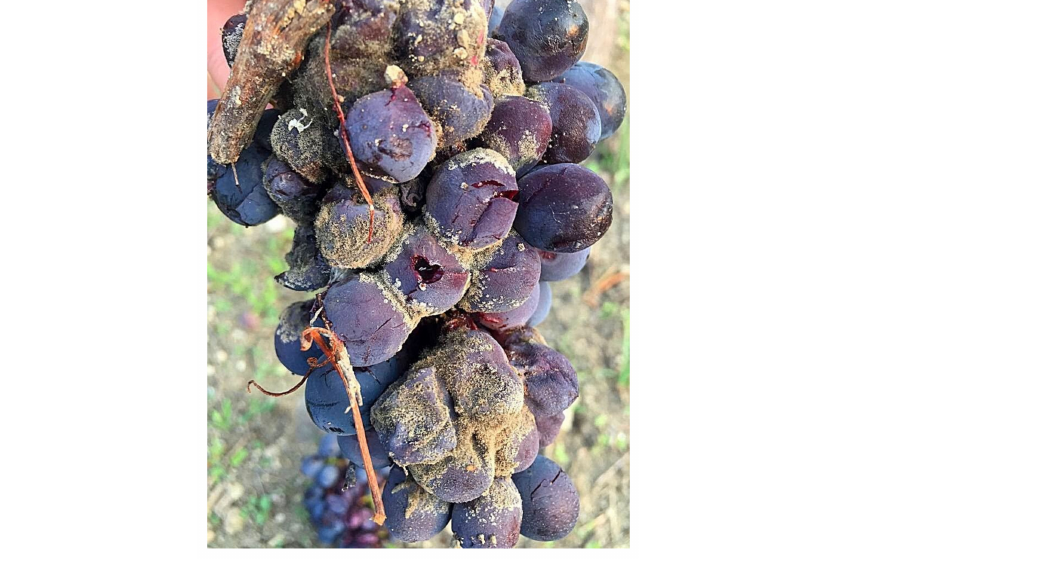
Figure 3. Symptoms observed on bunches of Nero d’Avola caused by Botrytis cinerea .